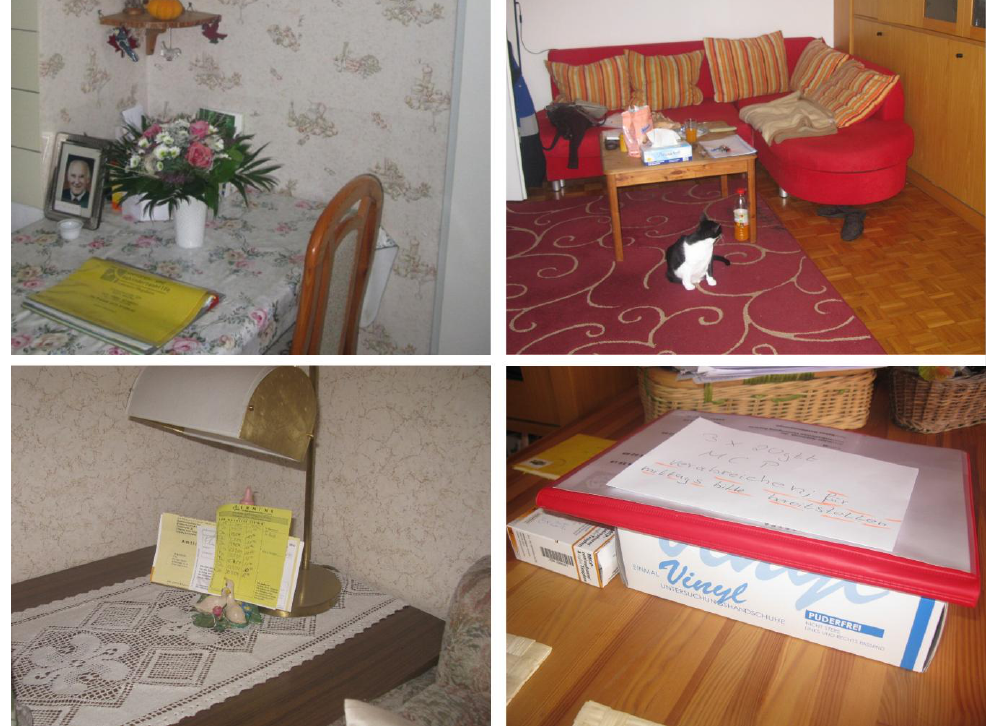
Figure 2. A special location in every home where important things are kept.